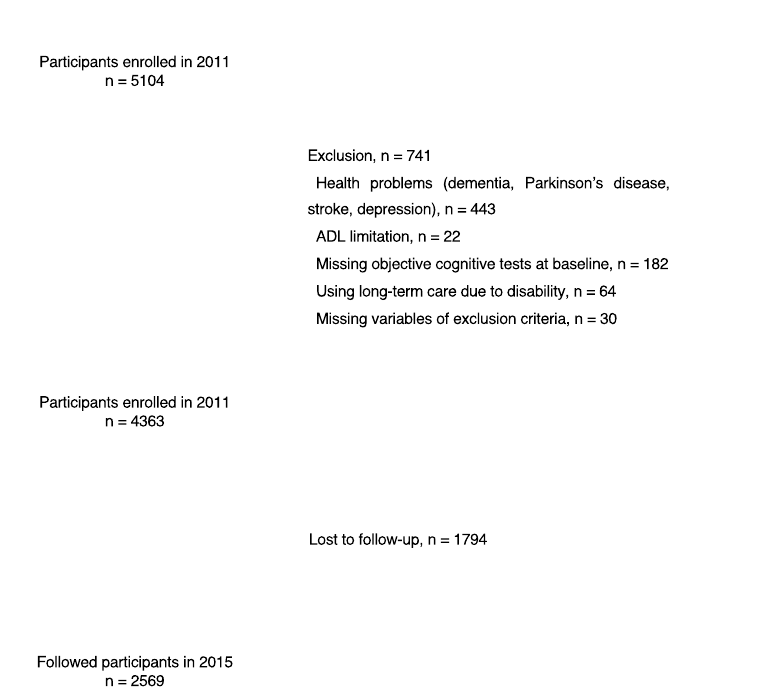
Figure 1. Flow diagram of sample selection. ADL, activities of daily living.